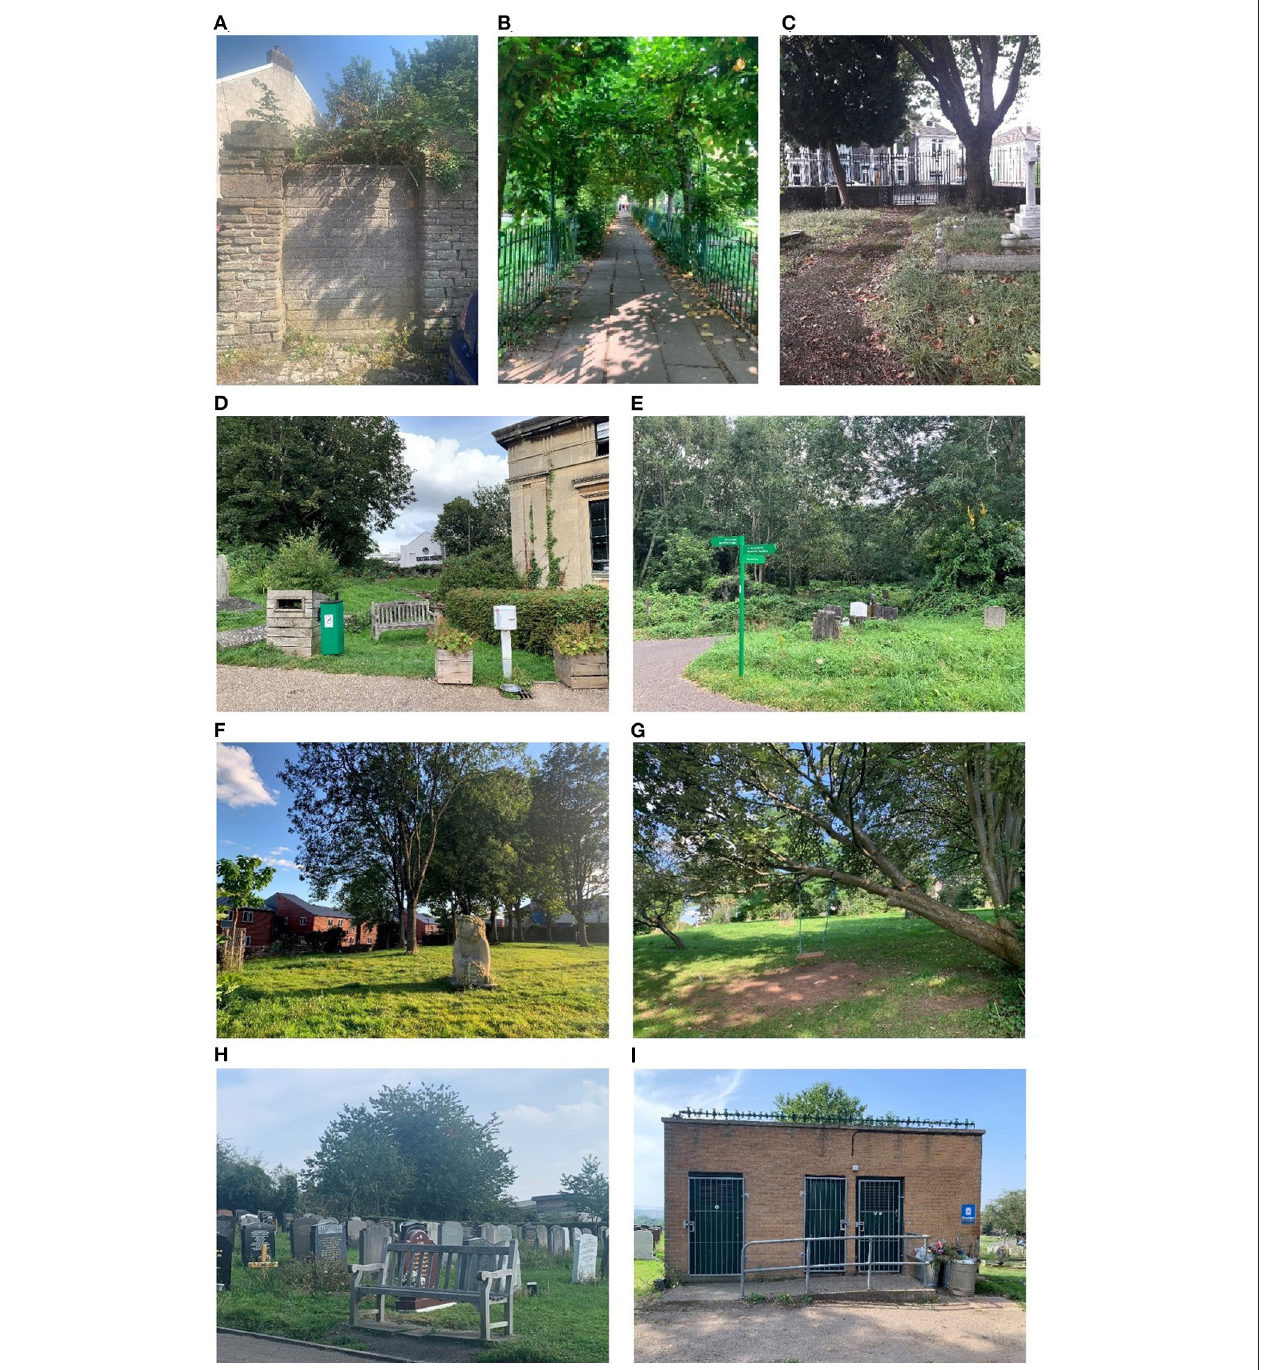
FIGURE 3 | Examples of access and amenities in (A) blocked access at Wesleyan Burial Ground, (B) Birdcage Walk, (C) path to Malago Greenway at St. John’s Burial Ground, (D) litter bins and seating and (E) signage at Arnos Vale, (F) sculpture on open space at John’s Churchyard, (G) informal tree swing and open space at St. John’s Burial Ground, (H) formal graves and seating and (I) closed public toilets at Avonview Cemetery.